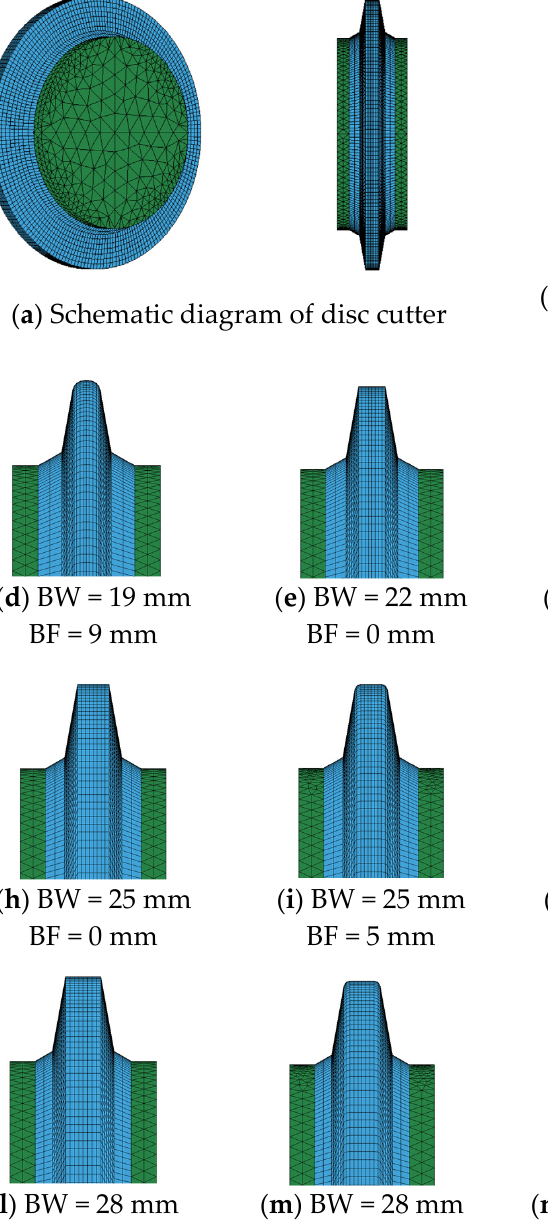
Figure 12. Fourteen different blade types of disc cutters.